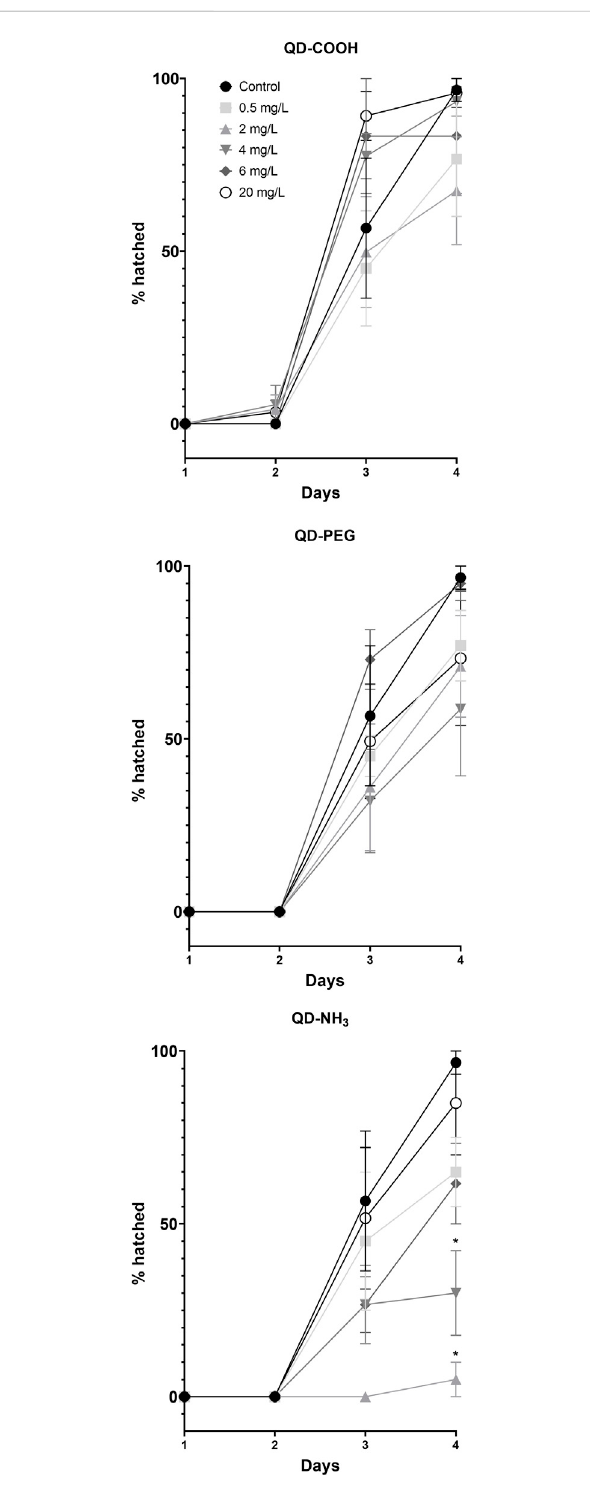
FIGURE 6 Percentage hatched Danio rerio larvae at different time points during the exposure to QD-COOH, QD-PEG and QD-NH 3 . Error bars represent standard deviation. Single asterisk (*) differences from control ( p < 0.05, T